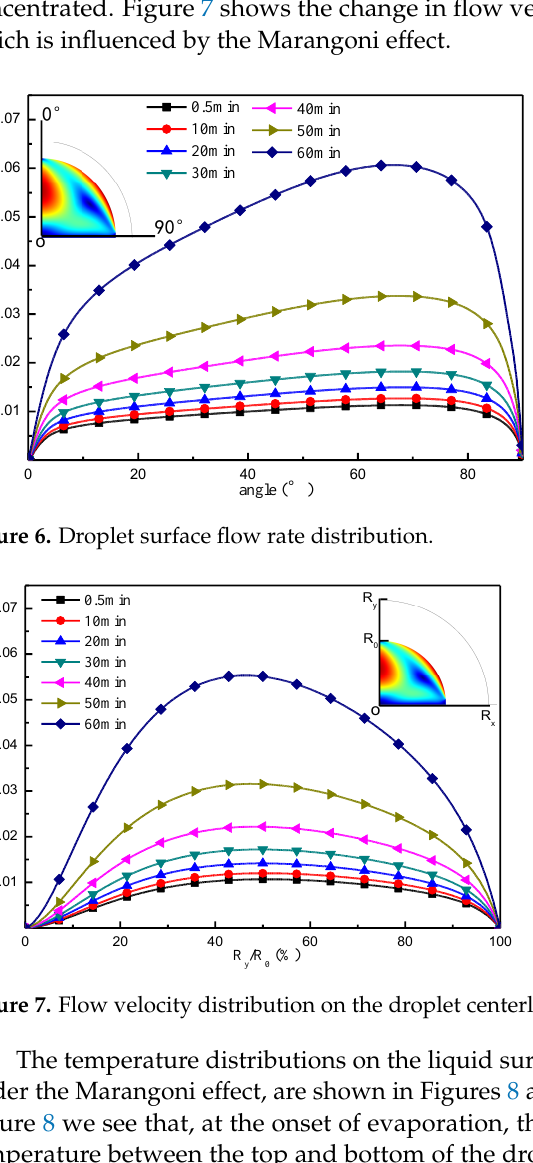
90° o Figure 8. Droplet surface temperature distribution.